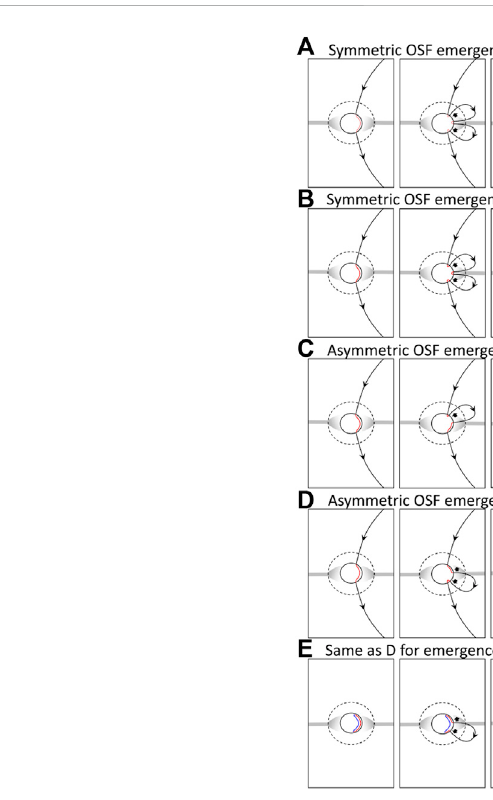
FIGURE 9 Topologicalsequencesdue toemergence,magneticreconnection(inboththepolarcoronalholesandintheheliosphericcurrent sheet,HCS), and transequatorial transfer of fl ux. All panels consider the situation after the polar fi elds have fl ipped and do not consider longitudinal structure which would allow different topologies to exist simultaneously at different longitudes. In panels (A – D) the poloidal fi eld emerging is topologically connected to OSF in the heliosphere, and only (E) deals with emergence from poloidal fi eld that remains in the sub-surface Sun. In each panel: the solid circle is the photosphere at r = R ⊙ ; the dashed circle is the source surface at r =2.5 R ⊙ ; the grey band is the HCS; and north is to the top. Red andbluelinesaresubsurface fi eldlineconnectivitiesat r < R ⊙ ,withred/bluesegmentshavinganetpoloidalcomponentthatissouthward/northward. Blackdotsarereconnectionsites,arrowedlinesaremagnetic fi eldlinesandblockarrowsgivethepolewardmotioncausedbymeridionalcirculation. Fromtoptobottomrowsarefor: (A) symmetric fl uxemergenceinthetwohemisphereswithoutreconnectionintheHCS; (B) symmetricemergence withreconnectionbetween thelower-latitudeleading-spotpolarity fi eldsintheHCS; (C) asymmetricemergence(in thenorthernhemisphereonly), without transequatorial fl ux transport; (D,E) asymmetric emergence (in the southern hemisphere only) with transequatorial transport of the fi eld of the leading-spot polarity. The difference between (D,E) is that in (D) the emergence is of magnetic fi eld lines that near the poles thread the photosphere and coronal source surface and so form OSF, whereas in (E) the emergence is of internal poloidal fi eld that never passes through the photosphere. The last 3 panels of sequences (D,E) also illustrate two ways in which closed fi eld lines (shown in green) can make OSF migrate equatorward. In (D) the closed loop straddles the HCS (so was generated from two loops with HCS reconnection or from one loop with transequatorial transport) but does not emerge through the source surface (and become open) until the polar OSF is disconnected (termed mechanism 1 in the text). In (E) both photospheric footpoints of the loop are in the southern hemisphere and interchange reconnection of the OSF gives “ footpoint jumping ” to a lower latitude (termed mechanism 2 in the text). Note that the time differences between frames are not fi xed and so different sequences take place over different timescales. Schematics based on those by Schrijver et al. (2002) and Lockwood et al.